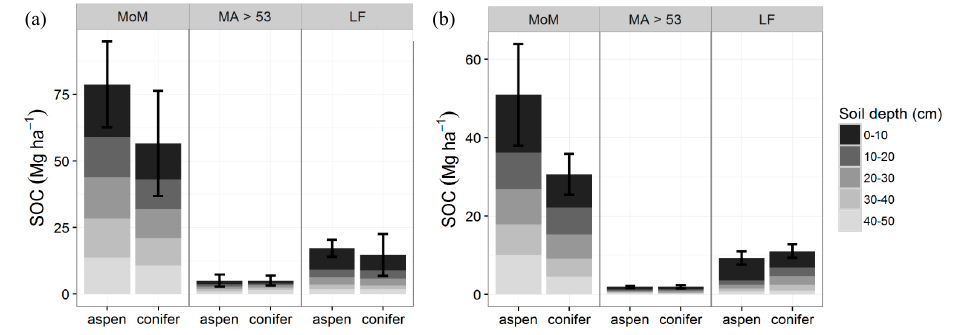
Figure 3. Pool sizes of the three major SOC fractions mineral associated organic matter (MoM) in the silt and clay fraction, MA > 53—mineral associated SOC in the sand fraction, LF—light fraction (Mg · ha − 1 ) at TWDEF (average of three plots) ( a ) and CM (average of four sites) ( b ). Error bars are standard deviations for the whole profile (MoM: p = 0.15, ES = 0.78; MA: p = 1, SE = 0.002; LF: p = 0.53, t = 0.69, SE = 0.31).